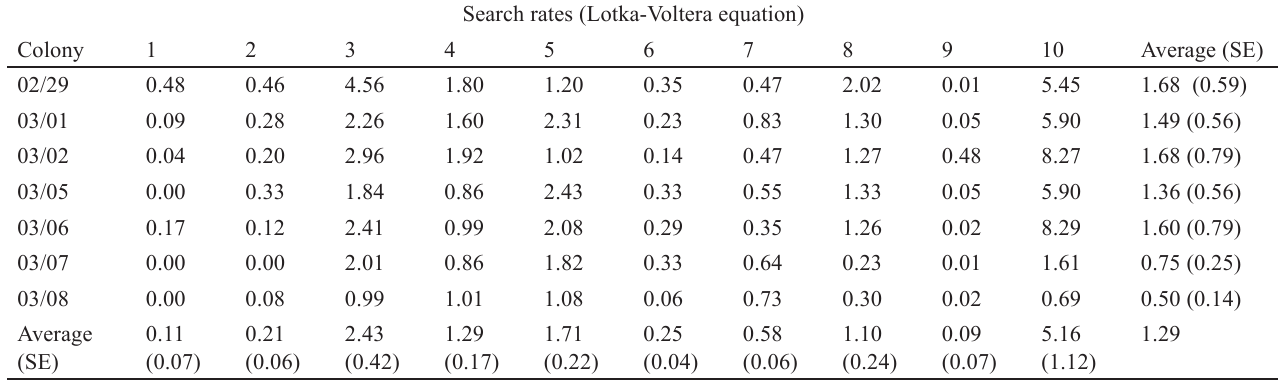
Table 3 . The estimated search rates (×10 -3 ) per observation period (45 min) for each colony on each day using the Lotka-Volterra functional response